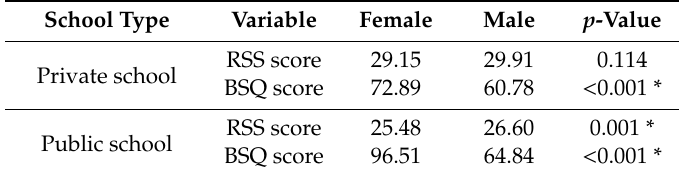
Table 1. Mean values reported for the variables analysed.